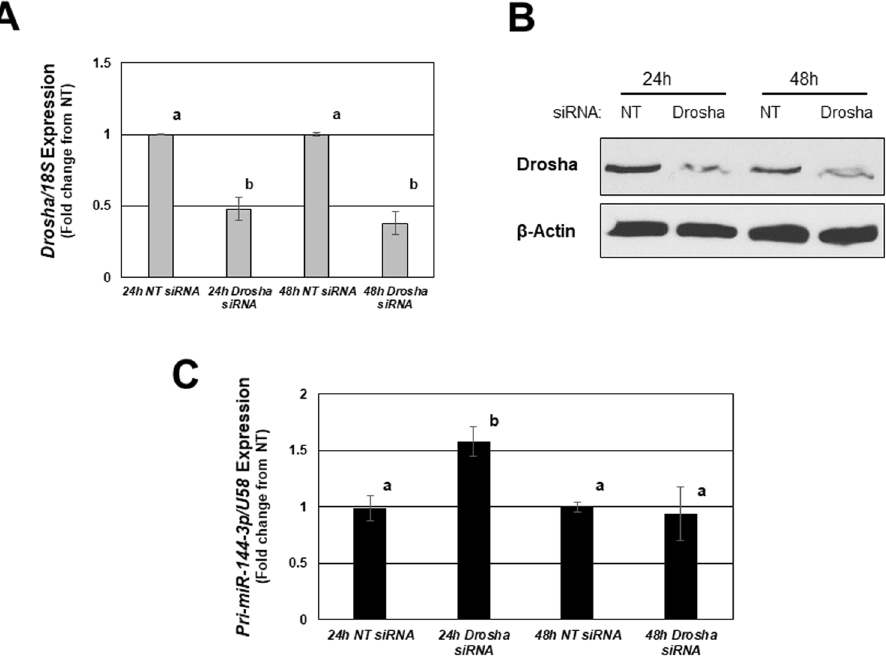
Figure 6. Inhibition of the miRNA processing enzyme, DROSHA, enriches endometriotic lesion expression of pri- miR-144-3p but not pri- miR-451a . The endometriotic epithelial cell line, 12Z was transfected with either a non-targeting siRNA (NT; negative control) or DROSHA siRNA. Twenty-four and forty-eight hours after transfection, DROSHA mRNA ( A ) and protein ( B ) expression were determined as was pri- miR-144-3p ( C ) and pri- miR-451a (data not shown). Pri-miR-451a was not detected in any of the 12Z cell samples by qRT-PCR. Different letters indicate statistical significance (P < 0.01) among the means by one-way ANOVA followed by Bonferroni post-hoc analysis (planned